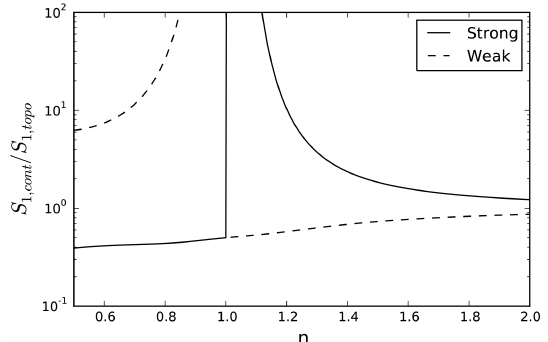
Figure 6. An example case of the ratio of slopes predicted by conti- nuity and topographic steady states. This example assumes a choice of equal rock thicknesses in both rock types and a weak rock erodi- bility that is twice that of the strong rock. Contrasts are in general strongest for n < 1 and gradually disappear for large n .